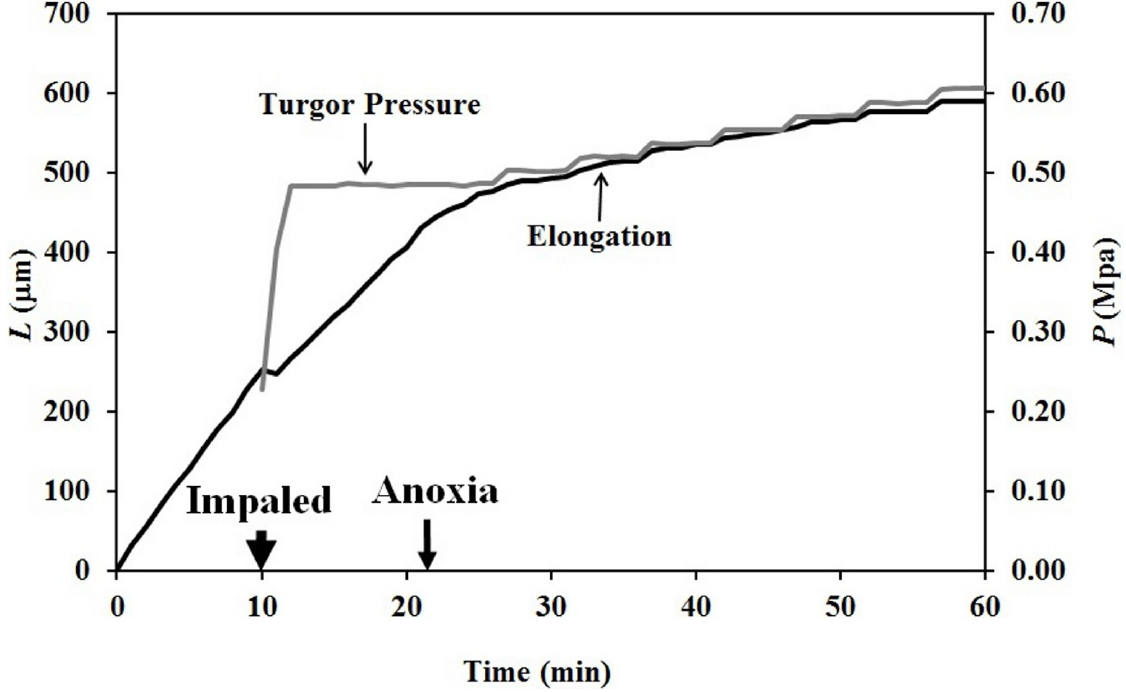
Figure 4. Both the change in elongation and turgor pressure of a Stage IV sporangiophore are plotted as a function of time. Approximately 5 min after anoxia, turgor pressure step-ups (approximately 0.021 MPa in magnitude and 5 min in duration) were produced with the pressure